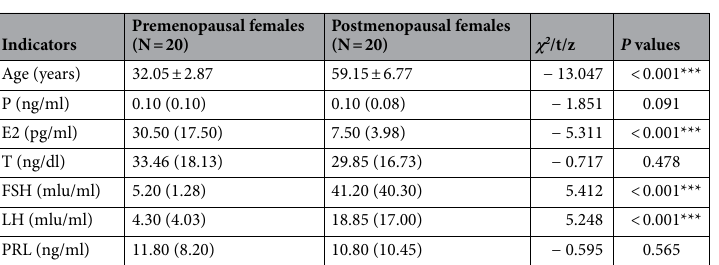
Table 1. Comparison of gonadal hormones between premenopausal females and postmenopausal females. * P < 0.05, ** P < 0.01, *** P < 0.001.